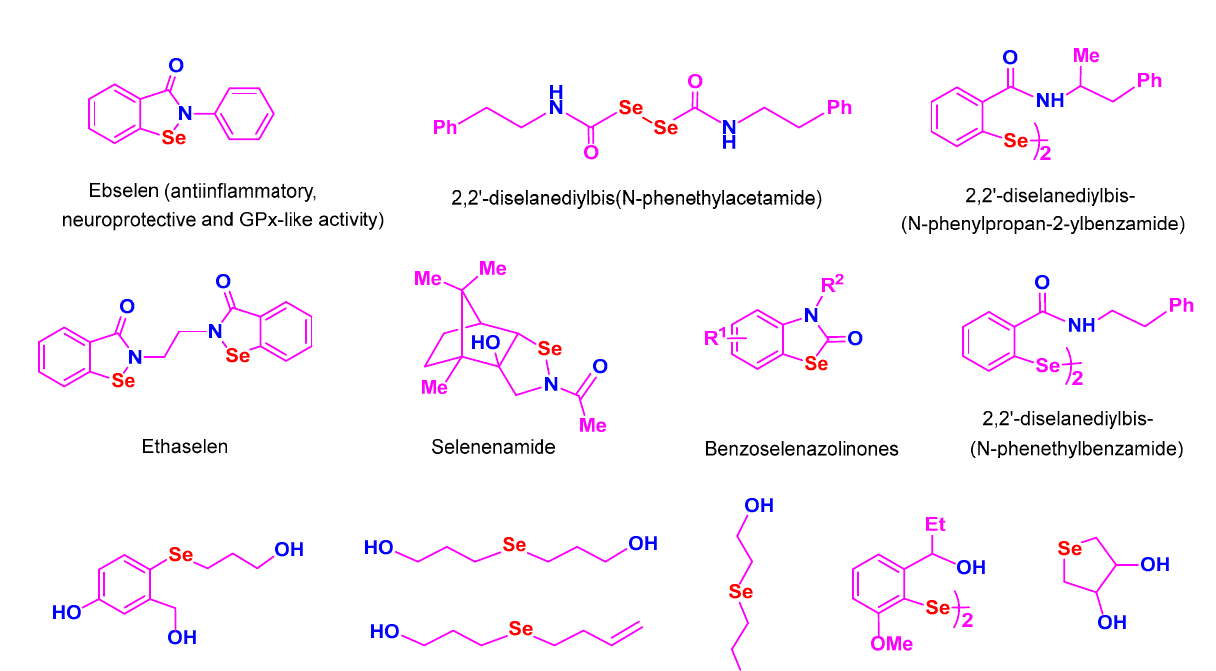
Figure 1. Examples of known functionalized organoselenium compounds with glutathione pe- roxidase-like activity including selenides with the hydroxyl groups [26–33]. Currently, selenium is recognized as an essential trace element for humans and plays an important role in the human body via selenium-containing enzymes. These enzymes (glutathione peroxidase, thioredoxin reductase, methionine sulfoxide reduc- tase, etc.) are involved in redox regulation in the body, reducing hydrogen peroxide and lipid peroxide species and maintaining antioxidant activity [34–36]. Sufficient intake of selenium is very important for the human body. It is known that low or suboptimal levels of selenium intake are associated with a wide range of human diseases such as heart disease, stroke, arthritis, cystic fibrosis, and even several types of cancer [34–36]. Sele- nium supplementation in the elderly is an important strategy for prevention of age-related diseases.